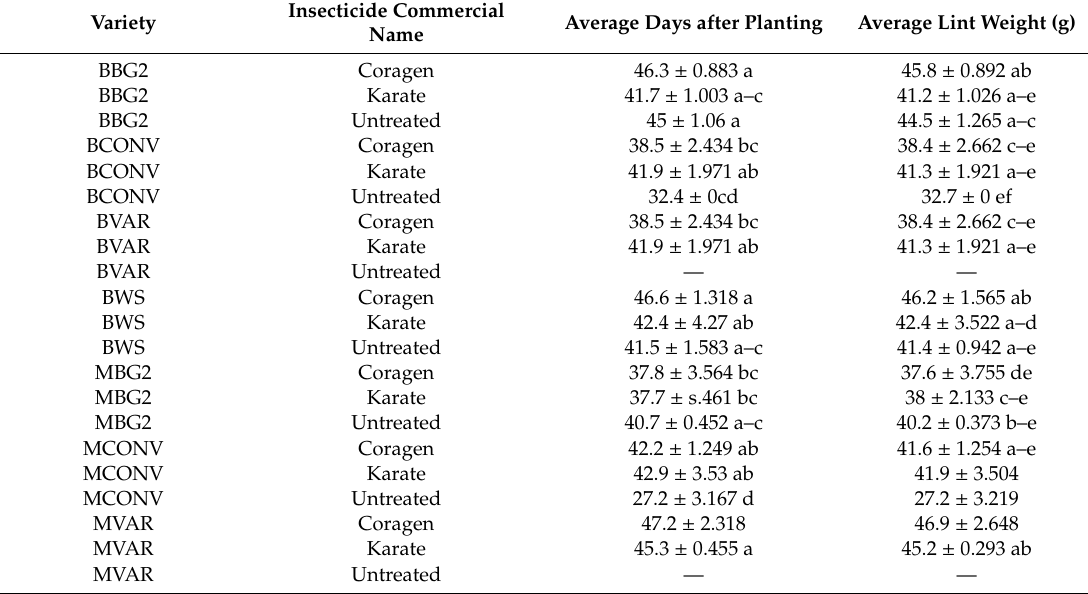
Table 9. Mean days after planting ± SEM of fruit initiation per surviving fruit and g of lint ± SEM harvested in 2011 box maps. Means not followed by a common letter indicate significant di ff erences between treatments based on LSD at p <